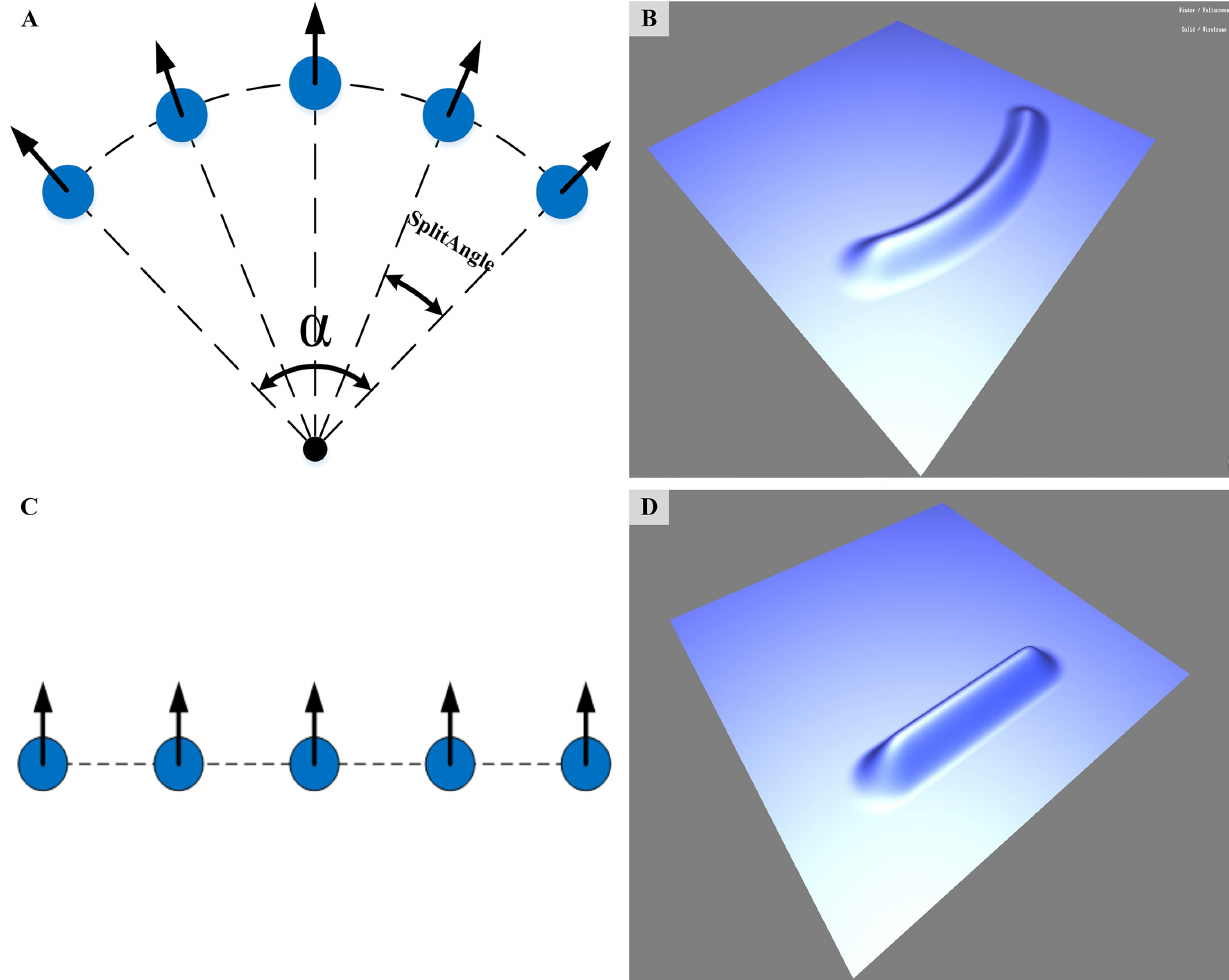
Fig 4. Initial wavefront shapes emitted from particle origin. (A) and (B) are the position of the wave particles and the radial wavefront shape they represent. (C) and (D) are the position of the wave particles and the parallel wavefront shape they